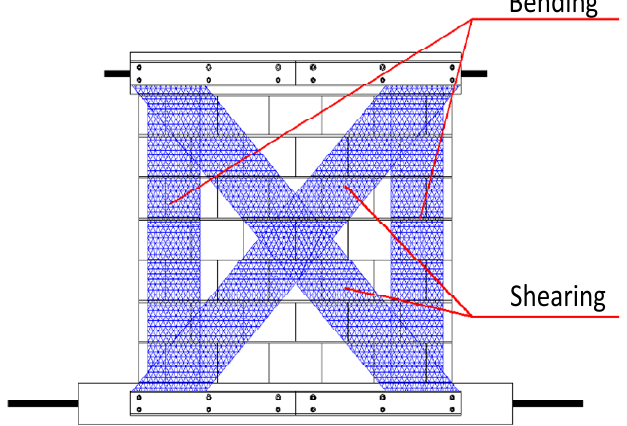
Figure 5. State of stress in retrofitted masonry